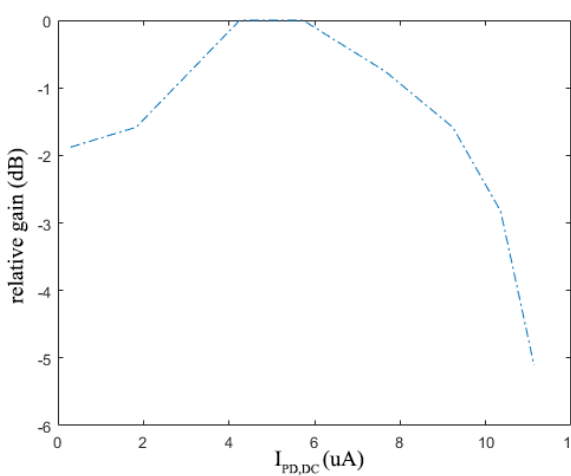
Figure 12. The noise response of the AFE.